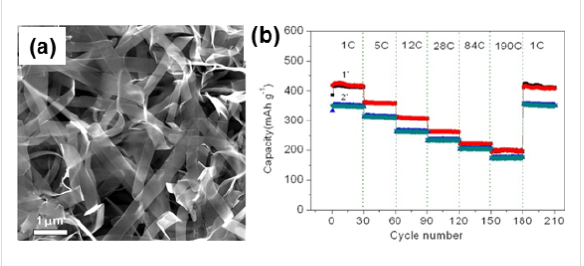
Figure 3: (a) Typical FE-SEM image of a VO 2 –graphene sample pre- pared by hydrothermal synthesis and reduction of a V 2 O 5 –graphite oxide composite for 1.5 and 12 h at 180 °C, demonstrating the forma- tion of numerous ribbons with a width of 200–600 nm and length of several tens of micrometres. (b) Rate capacities of VO 2 –graphene architectures with different VO 2 contents, measured for 30 cycles at each selected rate from 1 to 190 cycles. Reprinted (adapted) with permission from [111], copyright 2013 American Chemical